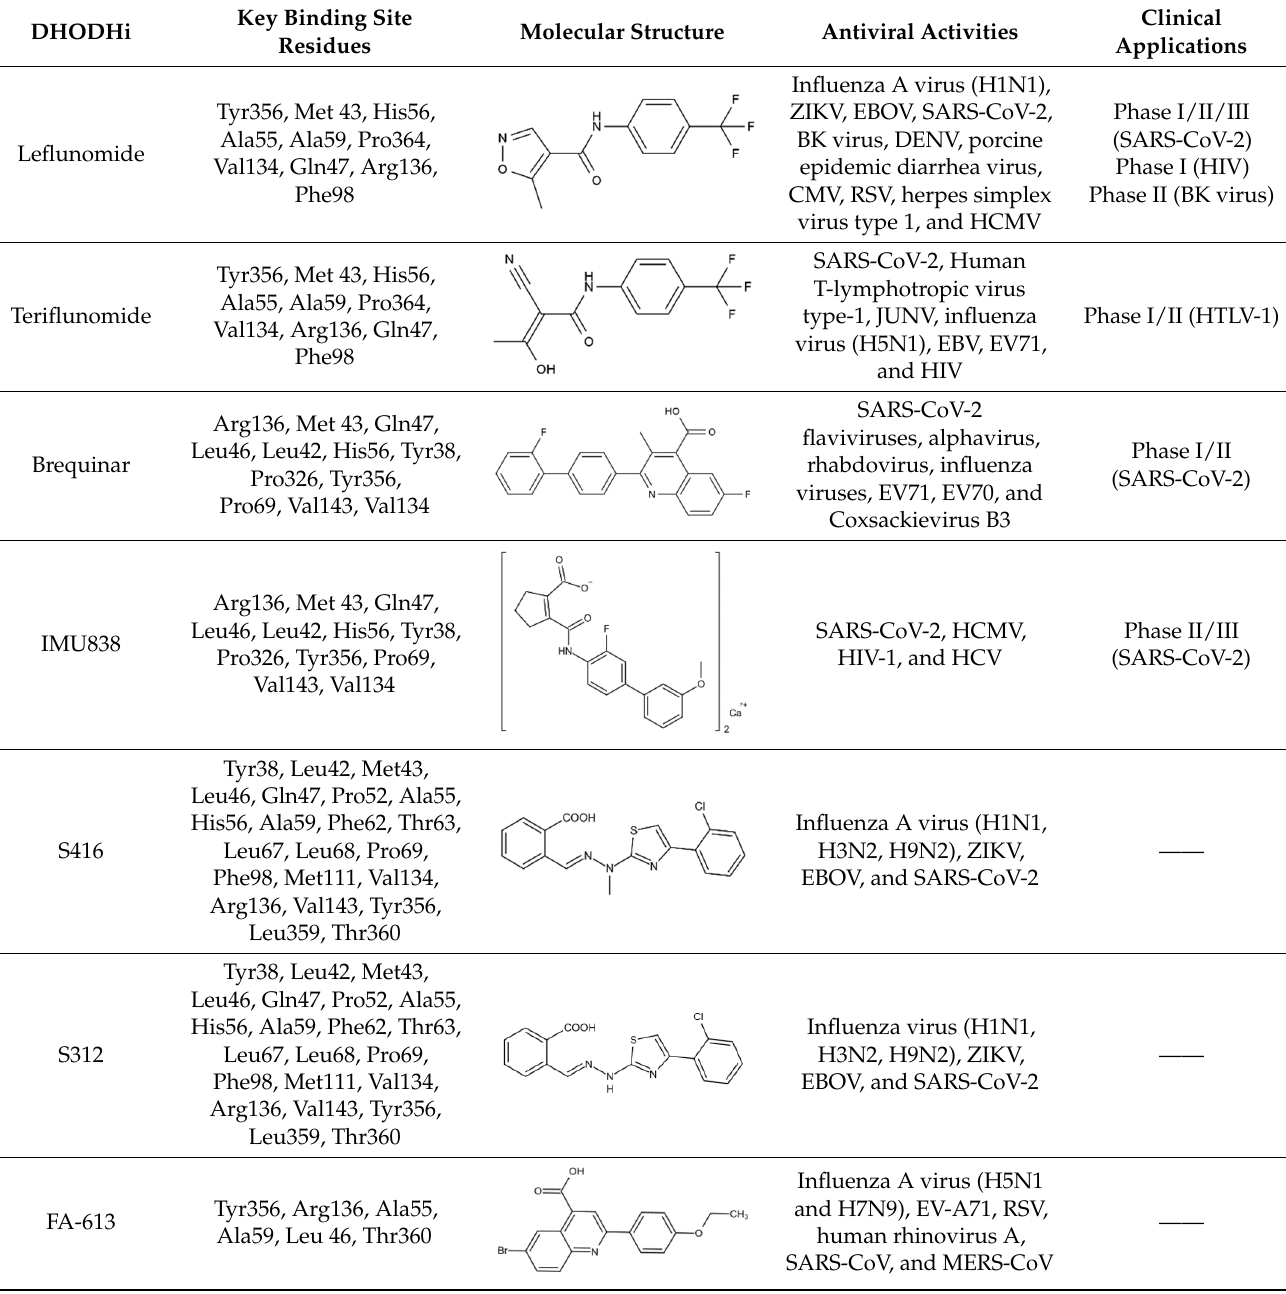
Table 2. Ongoing research of DHODHi in antiviral infections.